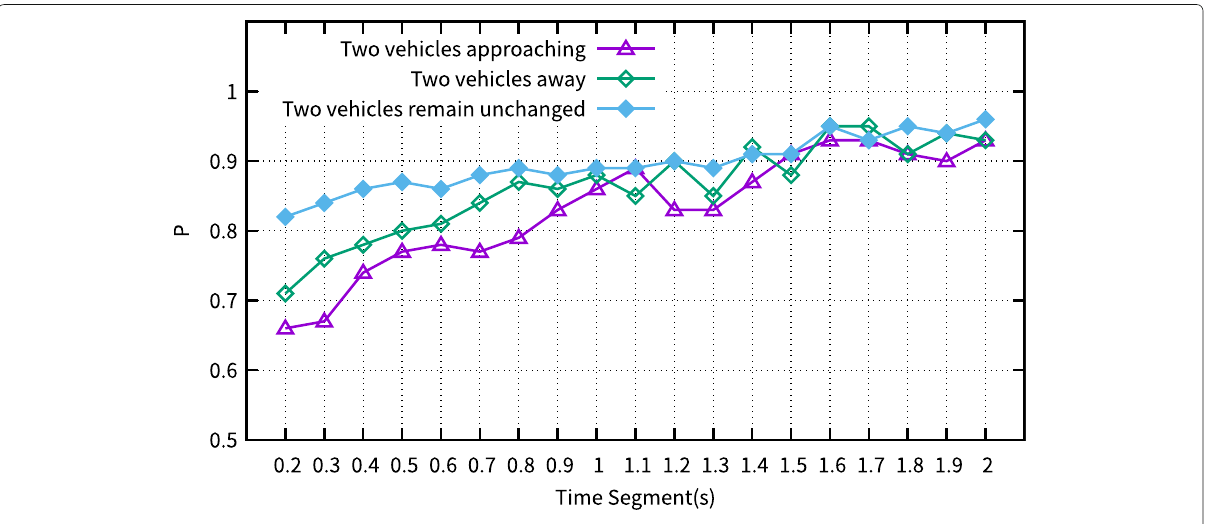
Fig. 7 Correct rate when two vehicles are traveling in the same direction